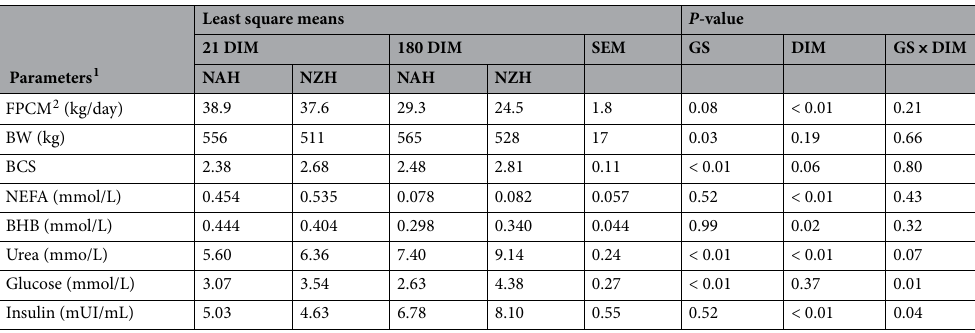
Table 1. Least square means, standard error of the mean (SEM) and ANOVA fixed effects of productive variables and metabolite and endocrine concentrations for North American (NAH, n = 8) and New Zealand (NZH, n = 8) Holstein genetic strains (GS) at 21 and 180 days in milk (DIM) on grazing systems. 1: Parameters abbreviations: BW: body weight; BCS: body condition score; NEFA: non-esterified fatty acids, BHB: β -hydroxybutyrate. FPCM: fat and protein corrected milk, presented as average milk yield of + / − 2.5 days the date in which the blood plasma samples were collected. FPCM was estimated according to Østergaard et al. 63 as follows: FPCM=Milk yield[(0.0383 × fat% + 0.0242 × protein% +